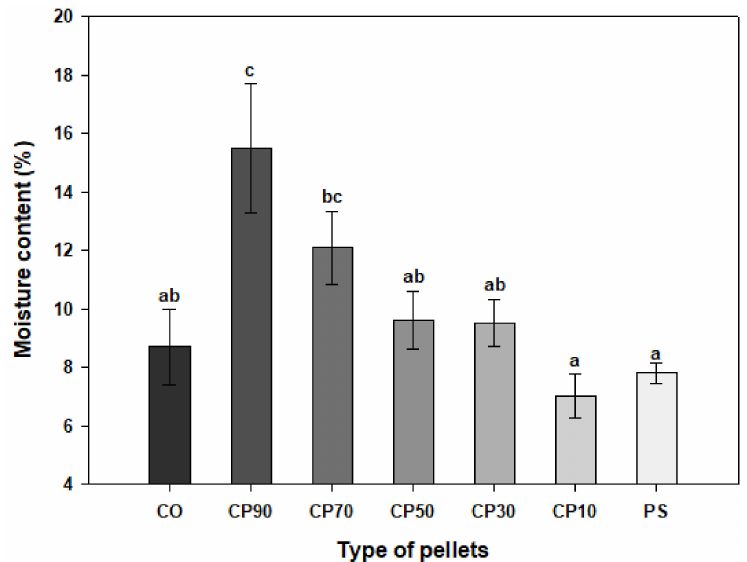
Figure 5. Pellet moisture content according to SCG blending ratio. Each point is the mean of three repeated measurements and is the mean ± standard deviation. The means with different letters (a–c) above the bars indicate significant differences based on Tukey’s HSD test ( p <